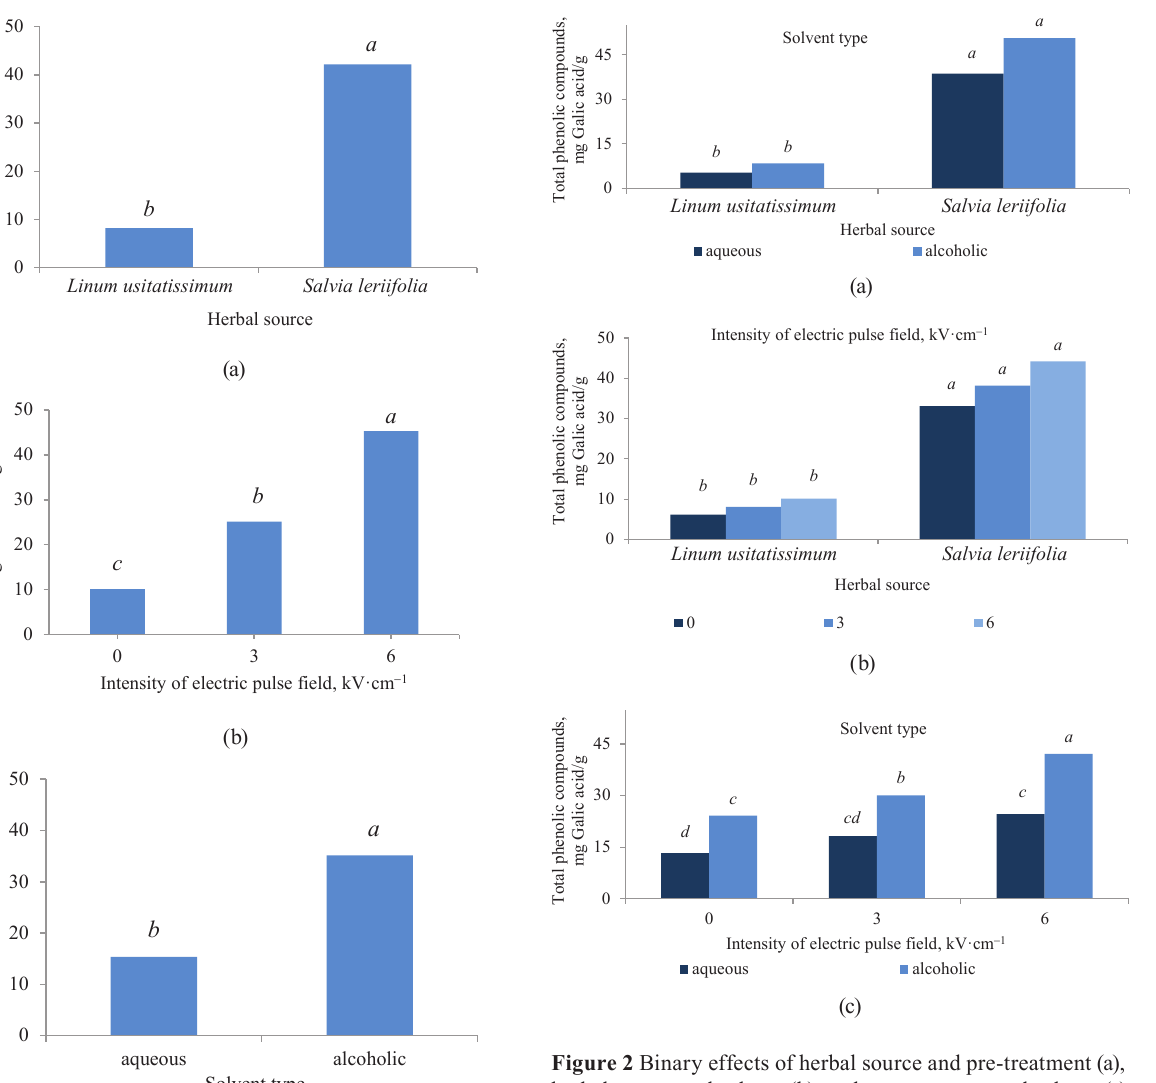
Figure 2 Binary effects of herbal source and pre-treatment (a), herbal source and solvent (b), and pre-treatment and solvent (c) on total phenolic compounds ( P < 0.05) Table 2 Interaction between herbal source, pre-treatment, and solvent type in their effects on total phenolic compounds Total